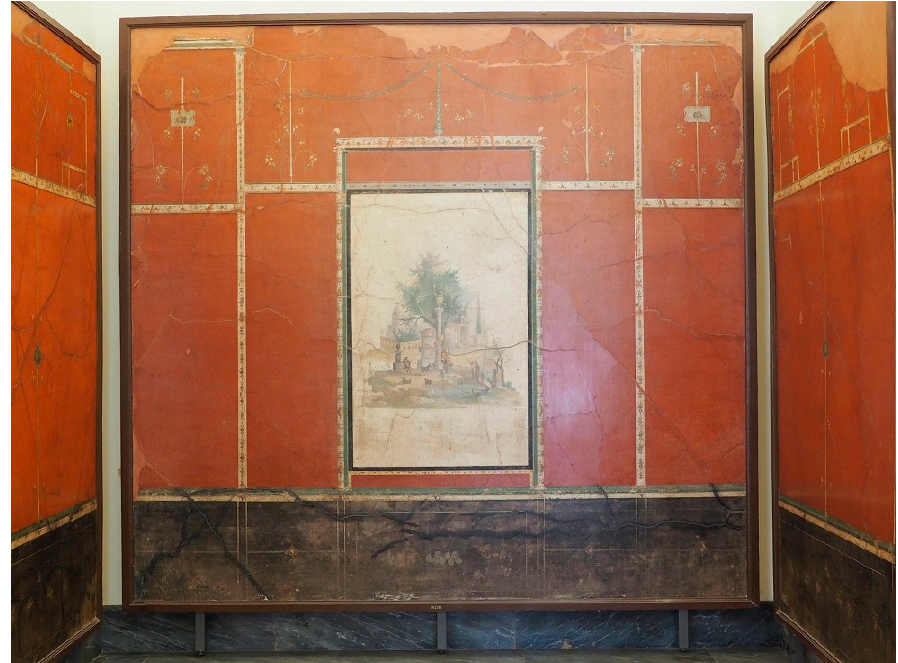
Figure 17. Cubiculum 16 of the Villa of Boscotrecase with its early third-style wall decoration, as